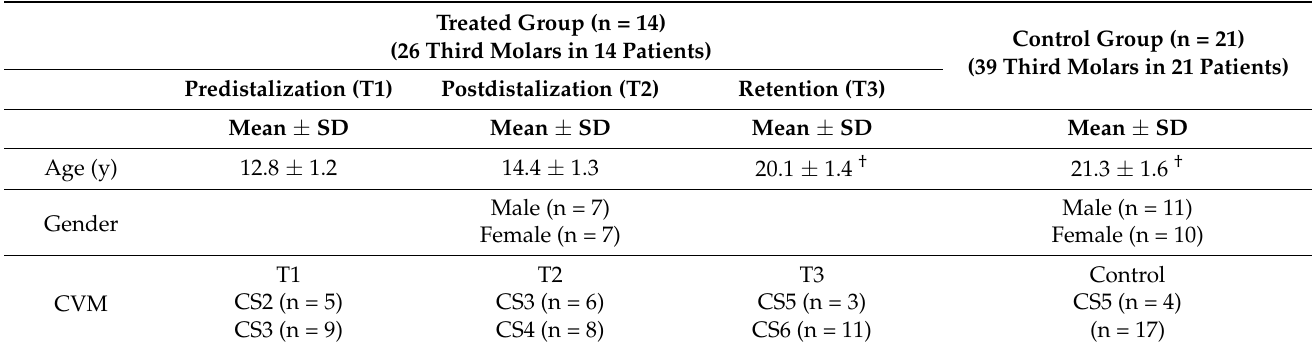
Table 1. Baseline characteristics of subjects in the treated and control groups. Treated Group (n =